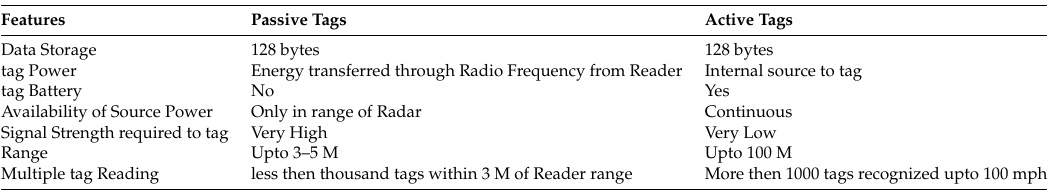
Table 1. RFID-tag